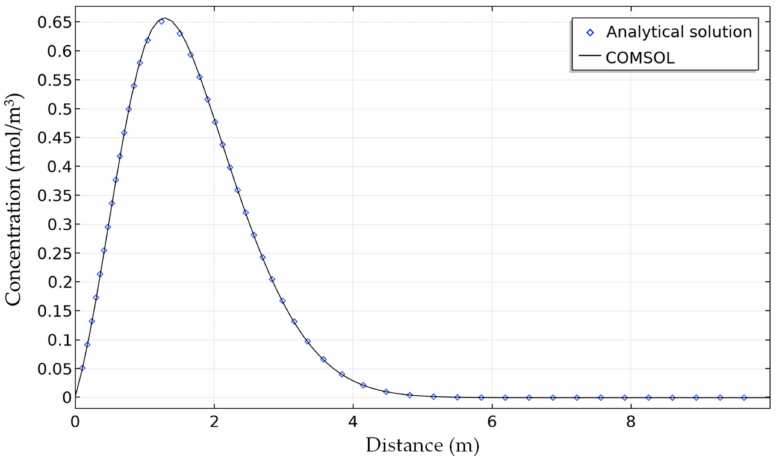
Figure 7. Comparison between COMSOL 1D transport model and analytical solution in the case of the transient-adsorbing